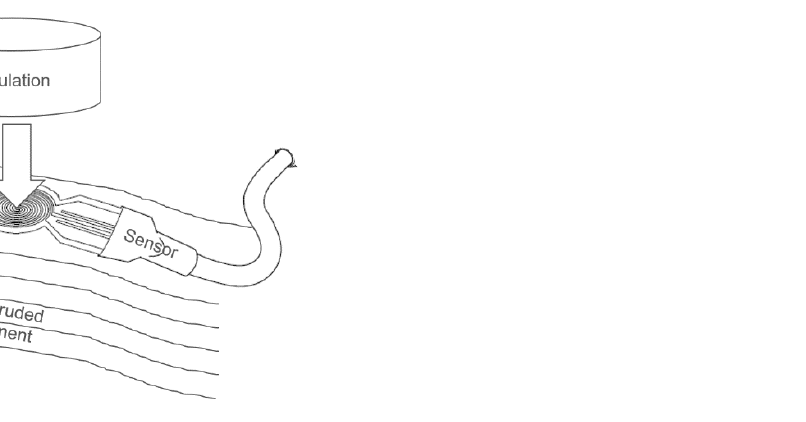
Table 1. Methodical requirements for the heat flux measurements [36] and their implementation in the conducted experiments.